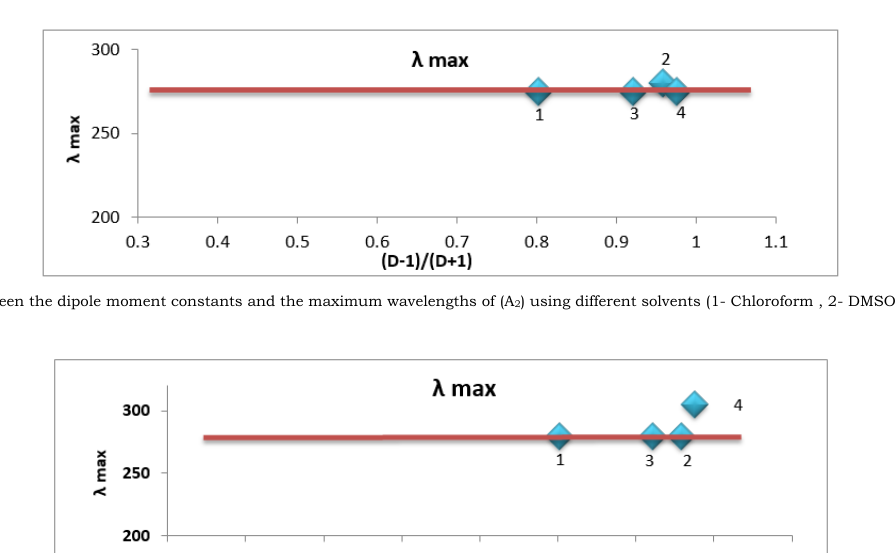
of buffer solution at pH (1-12) using 1*10 -4 M as seen in Figures 19, 20 and 21 below: